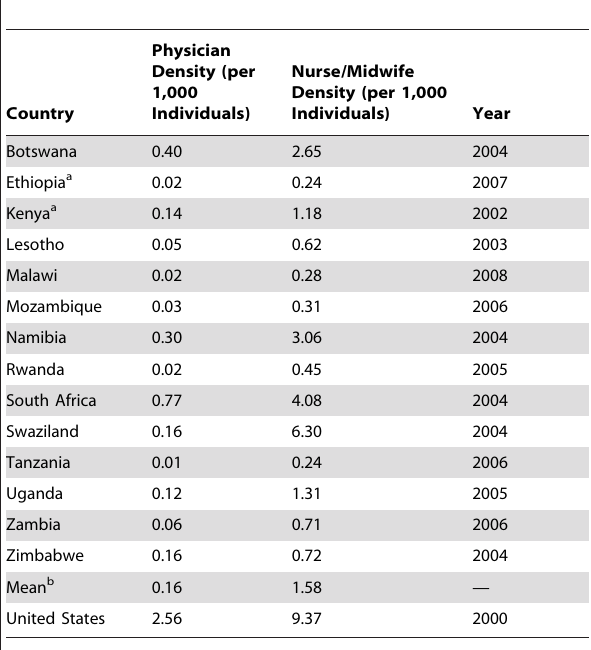
Table 1. Density of physicians and nurses/midwives in VMMC priority